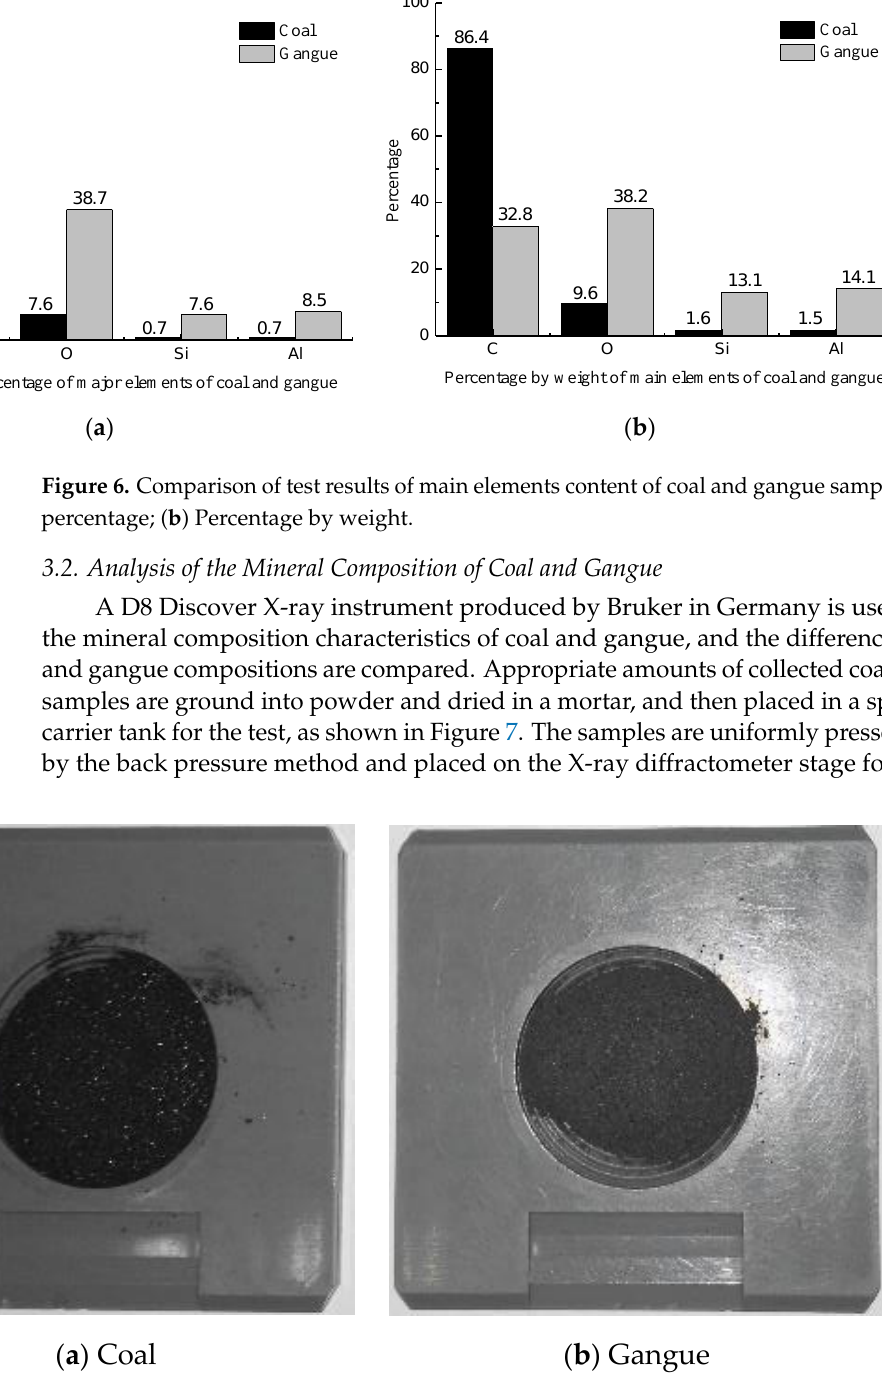
Figure 7. X-ray diffraction test sample.